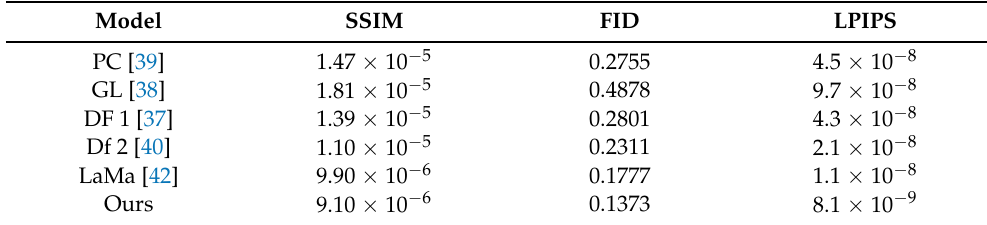
Table 2. Variances of quantitative comparison of the proposed method with already publicly available, robust baselines in FID, LPIPS, and SSIM metrics. The results of each model were derived from its public